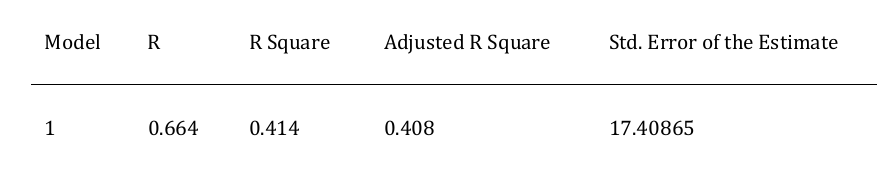
1 0.664 0.414 0.408 17.40865